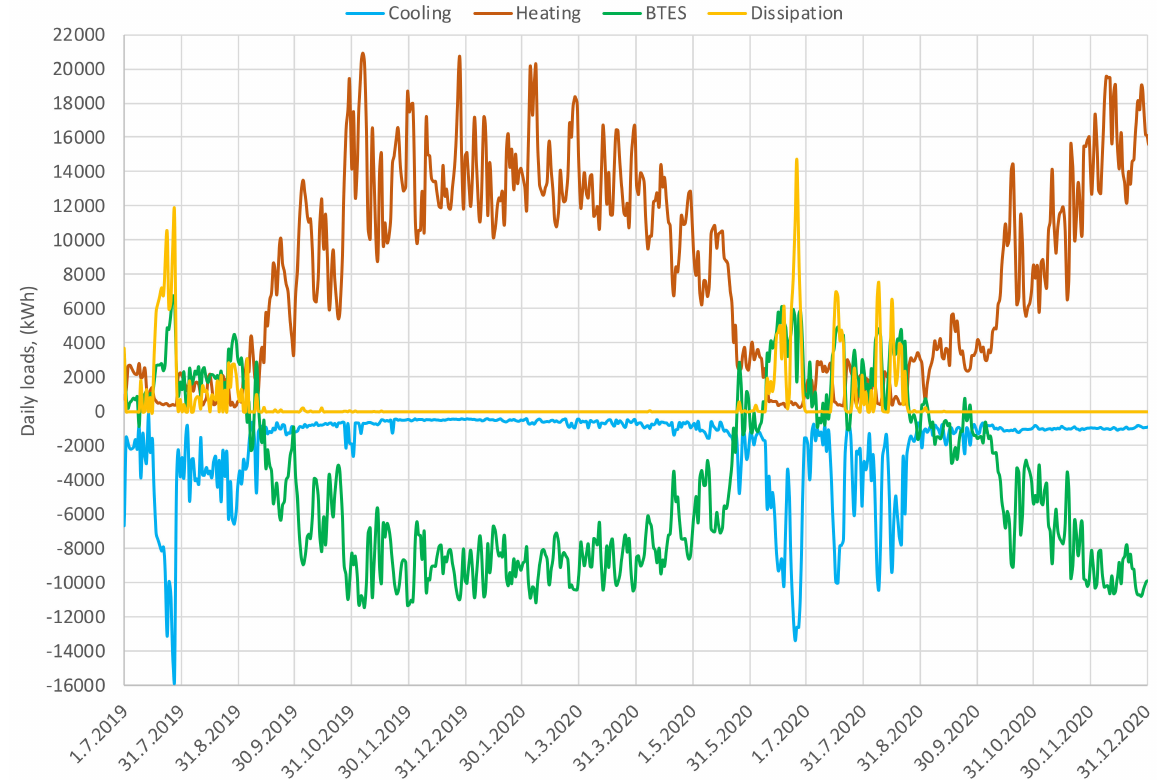
Figure 5. Daily loads after data management procedure.